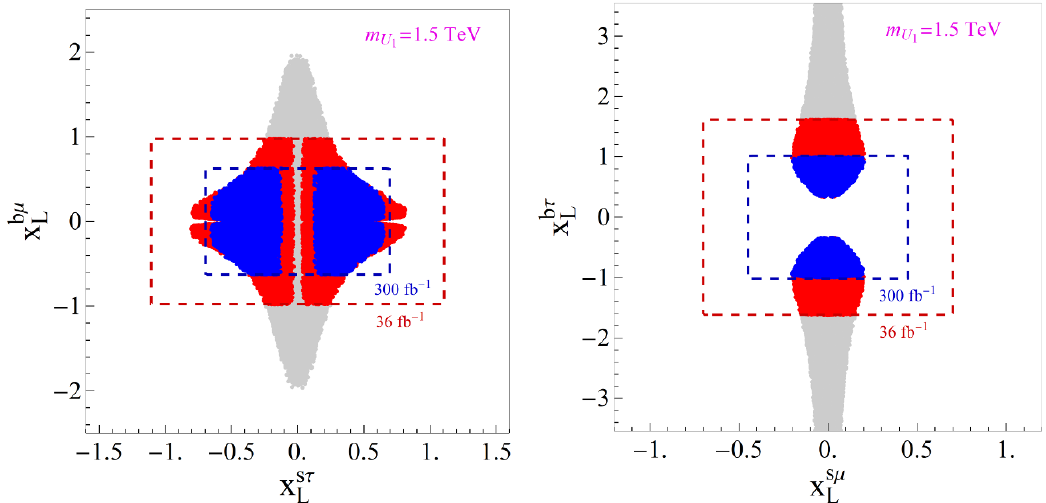
Figure 8 . Coupling x s(cid:28) panel), by assuming m U